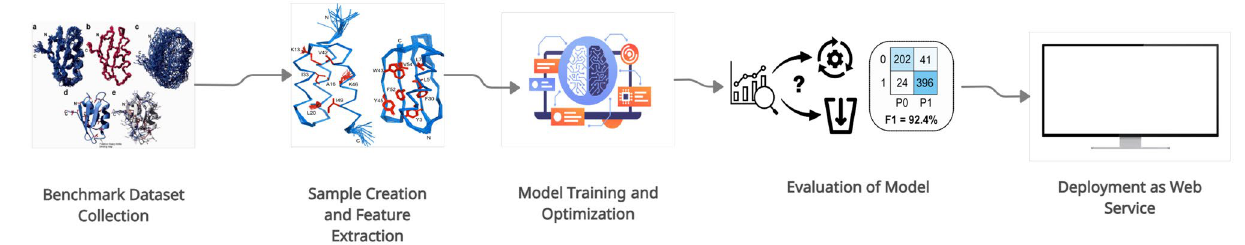
Figure 1. Chou’s five step